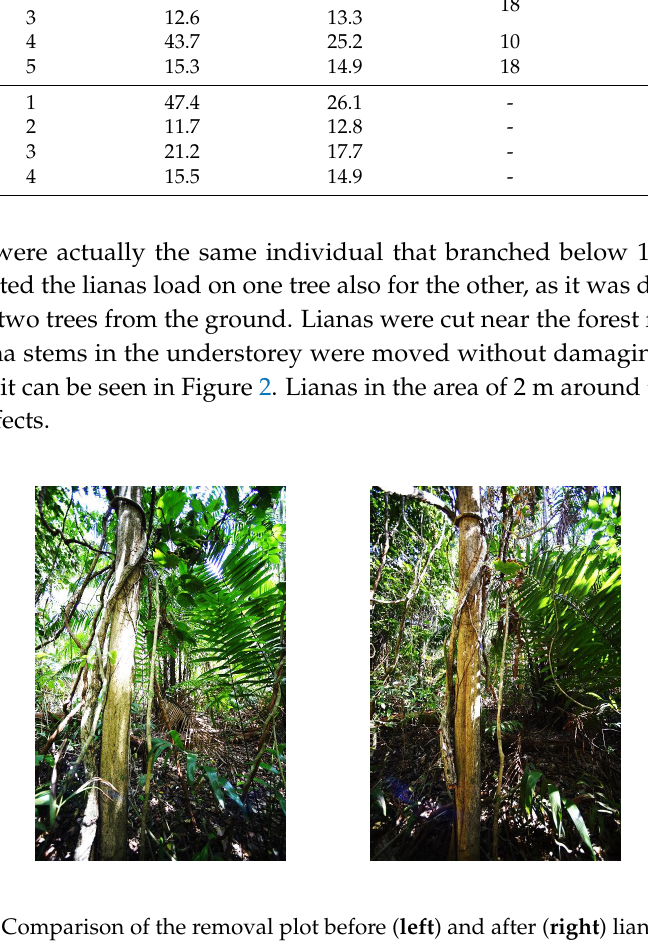
Figure 2. Comparison of the removal plot before ( left ) and after ( right ) liana